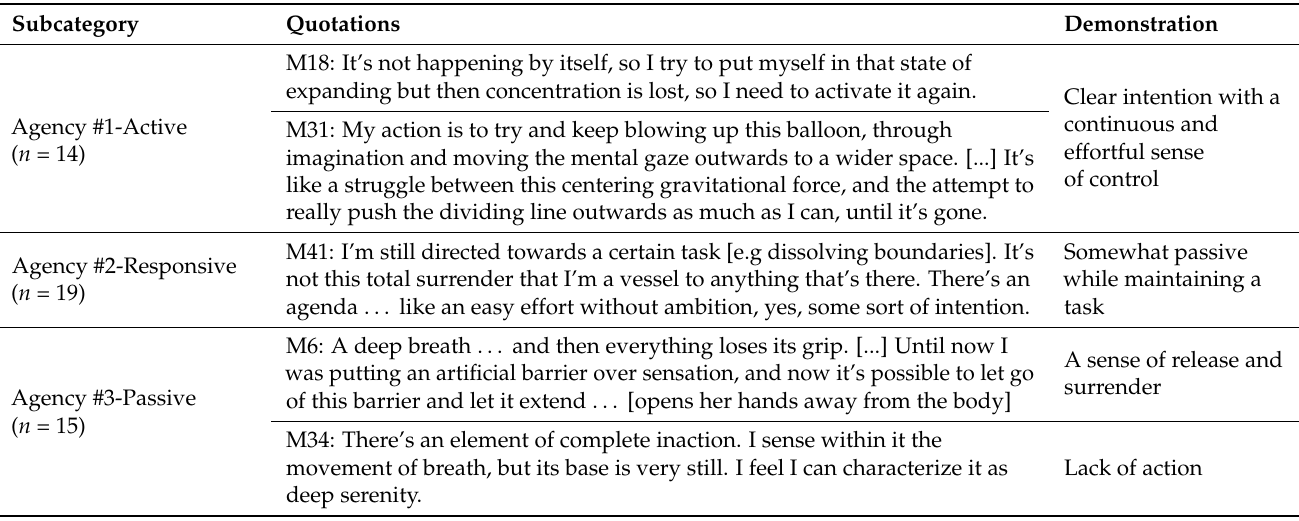
Table 8. SB − representative examples of sense of